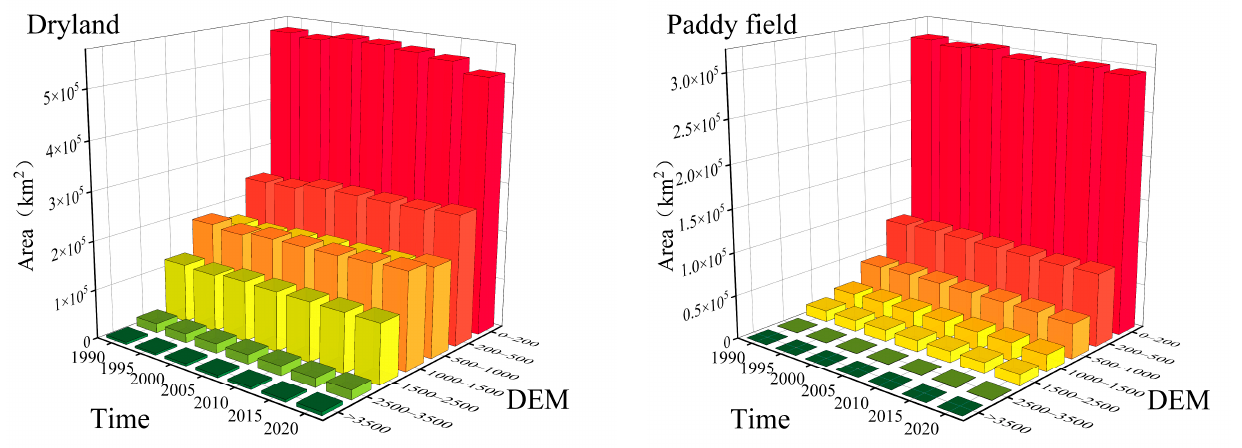
Figure 2. Changes in the elevations of paddy field and dryland. (For detailed data, refer to Table S2 in the Supplementary Materials).